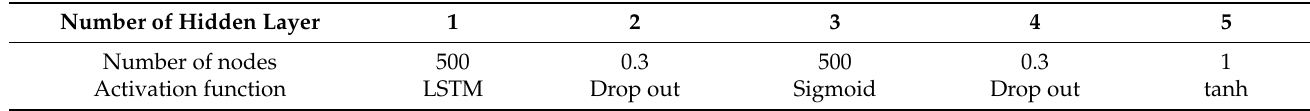
Table 8. The structure of the LSTM